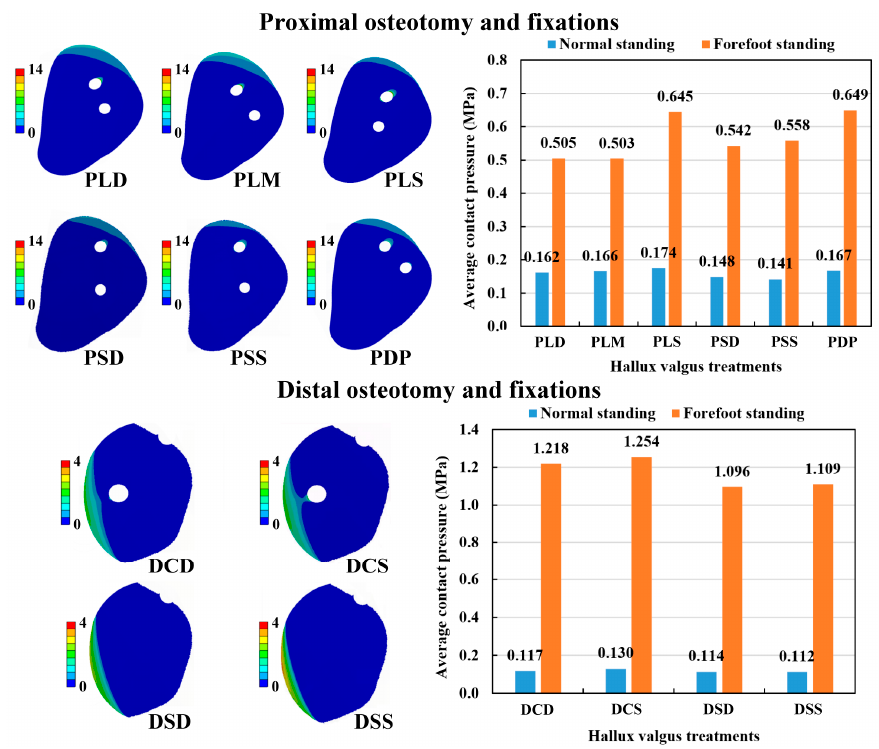
Figure 9. The contact pressure distribution on the osteotomy surface of the numerical models and the results of the average contact pressure.